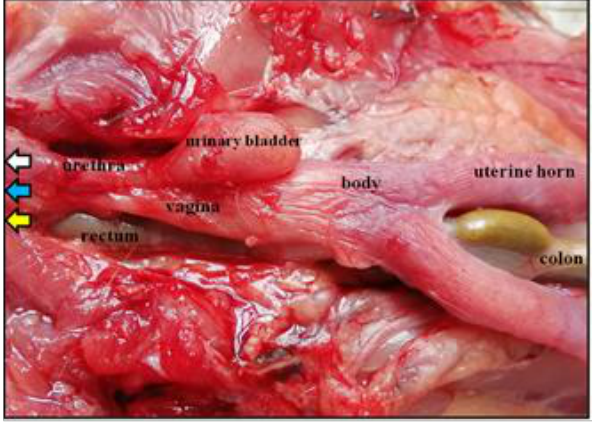
Figure 1. Uterus and vagina were dissected out. showed vagina, urethra, rectum, sites of openings of urethra (white arrow), vagina (blue arrow) and anus (yellow